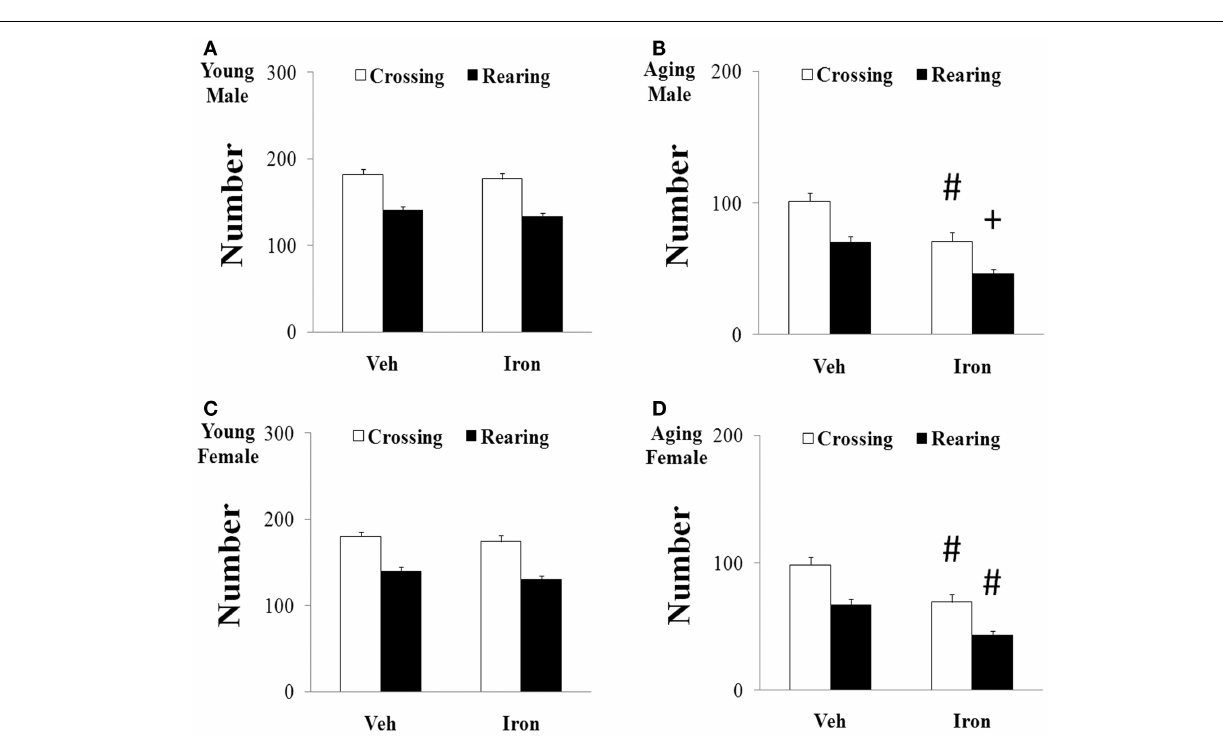
Frontiers in Aging Neuroscience |